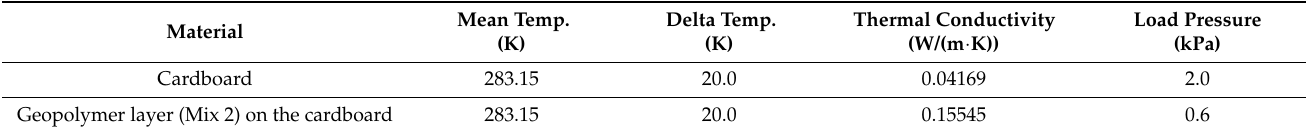
Table 7. Thermal conductivity and thermal resistance of the manufactured sample.